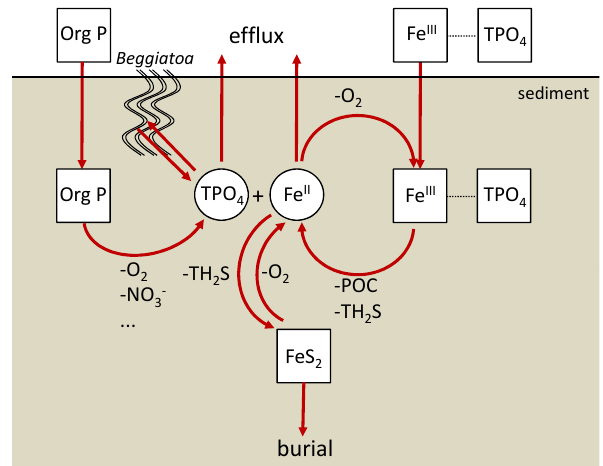
Fig. 1. Schematic of the coupled Fe and P cycles considered in the model. Solid species are in squares and solutes in circles. P is added to the sediment as organic P and with iron oxyhydroxides. Phos- phate is released to the porewater upon reductive dissolution of fer- ric iron and oxidation of organic matter. This dissolved P pool is free to be transported out of the sediment, or removed from the porewa- ter by co-precipitation with ferrous iron oxidation. P uptake and release by Beggiatoa is explored in Sect.